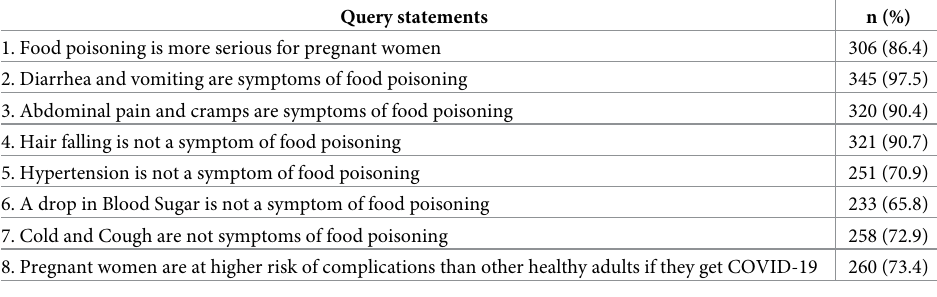
Table 8. Query statements and responses 1 to the “knowledge of foodborne diseases” aspect (n = 354).